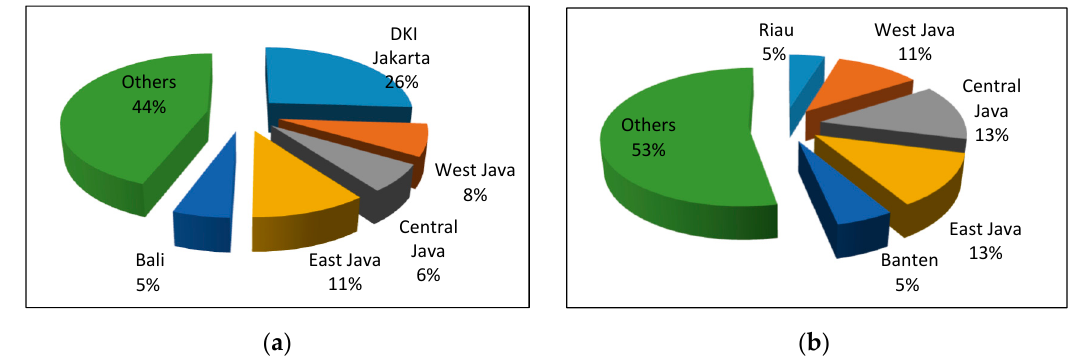
Figure 11. Comparison of the Top 5 provinces by number of cars ( a ) in 2015 ( b ) in 2050.